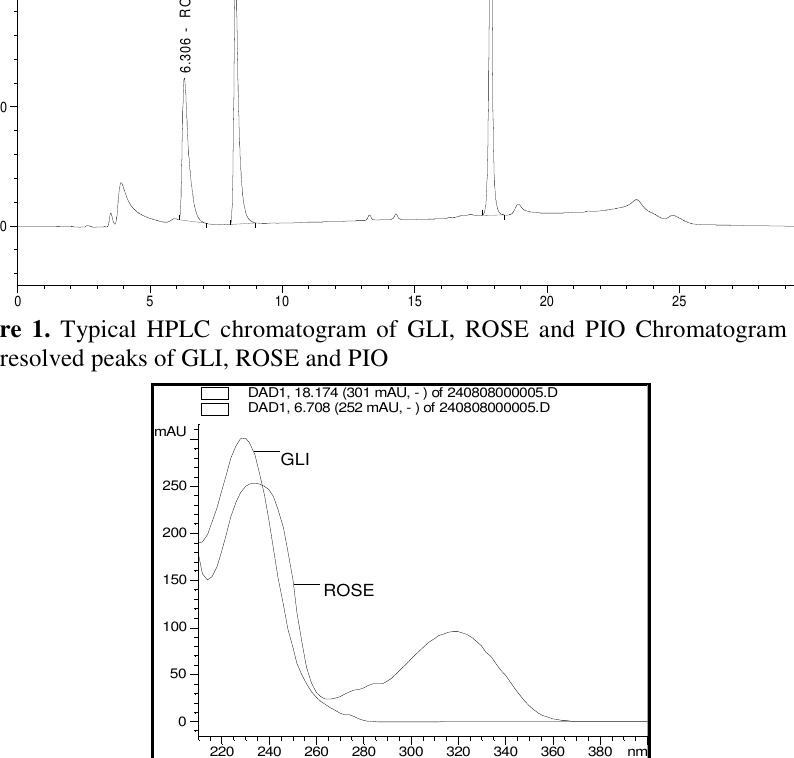
Figure 2. UV overlain spectra of GLI and